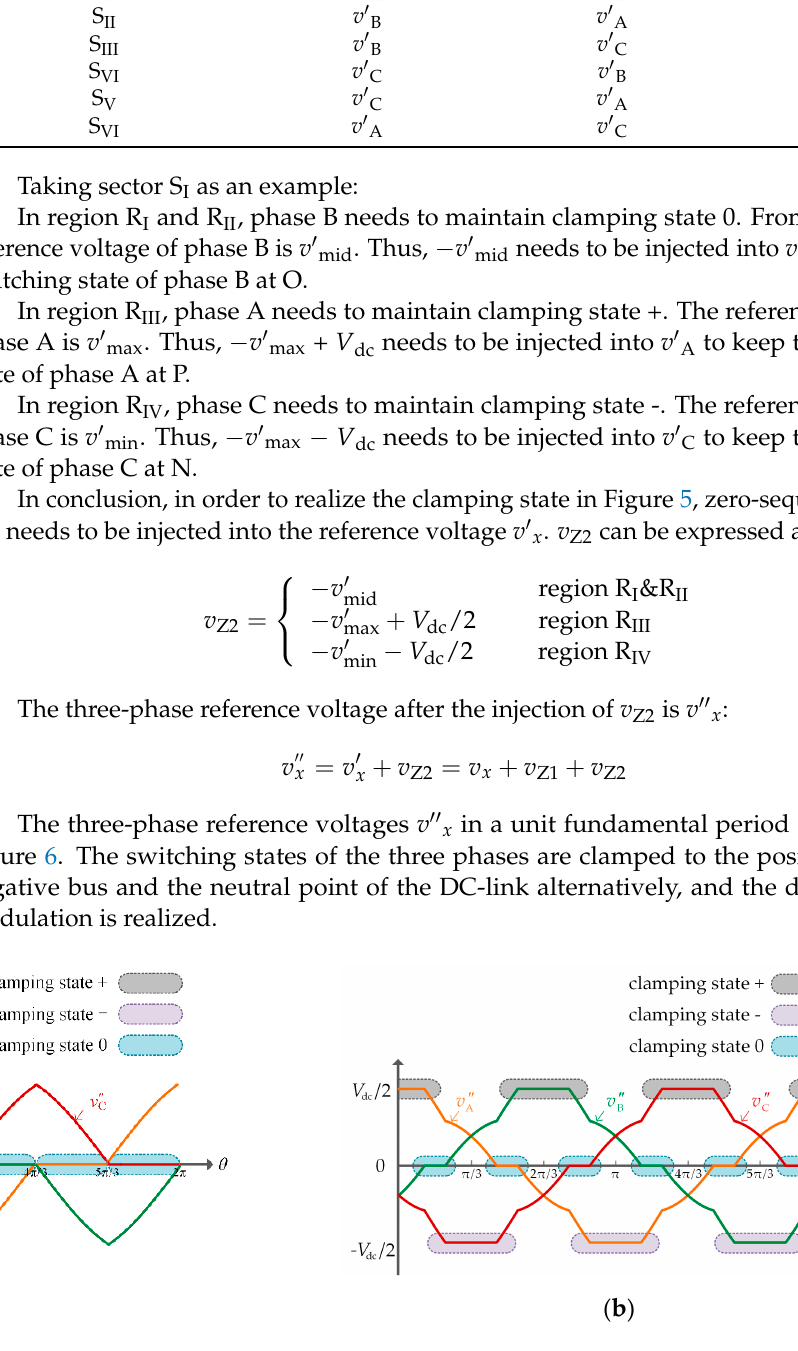
Figure 6. The reference voltage after the second injection of the zero-sequence voltage. ( a ) m = 0.3; ( b ) m = 0.8.